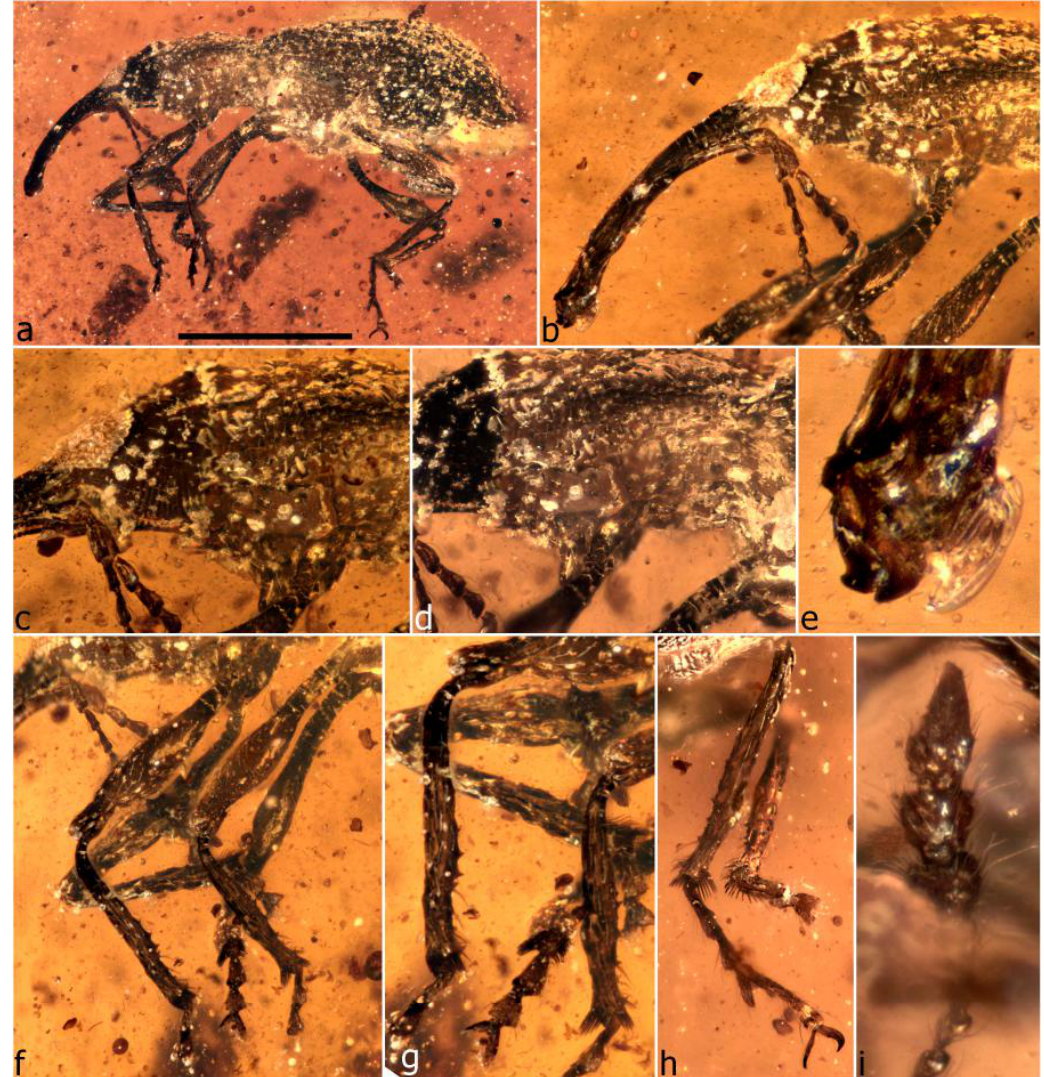
Figure 48. Electrocis dentitibialis sp. n., holotype. Habitus, left lateral ( a ); head and prothorax, left lateral ( b ); same, detail ( c–d ); apex of rostrum, left lateral, showing inner face of right mandible with two blunt apical cusps (left mandible cut away) ( e ); fore and middle legs ( f ); pro- and mesotibiae ( g ); hindlegs, showing complete left metatarsus ( h ); antennal club ( i ). Scale bars: 0.5 mm (a). Genus Debbia Clarke & Oberprieler, gen. n.